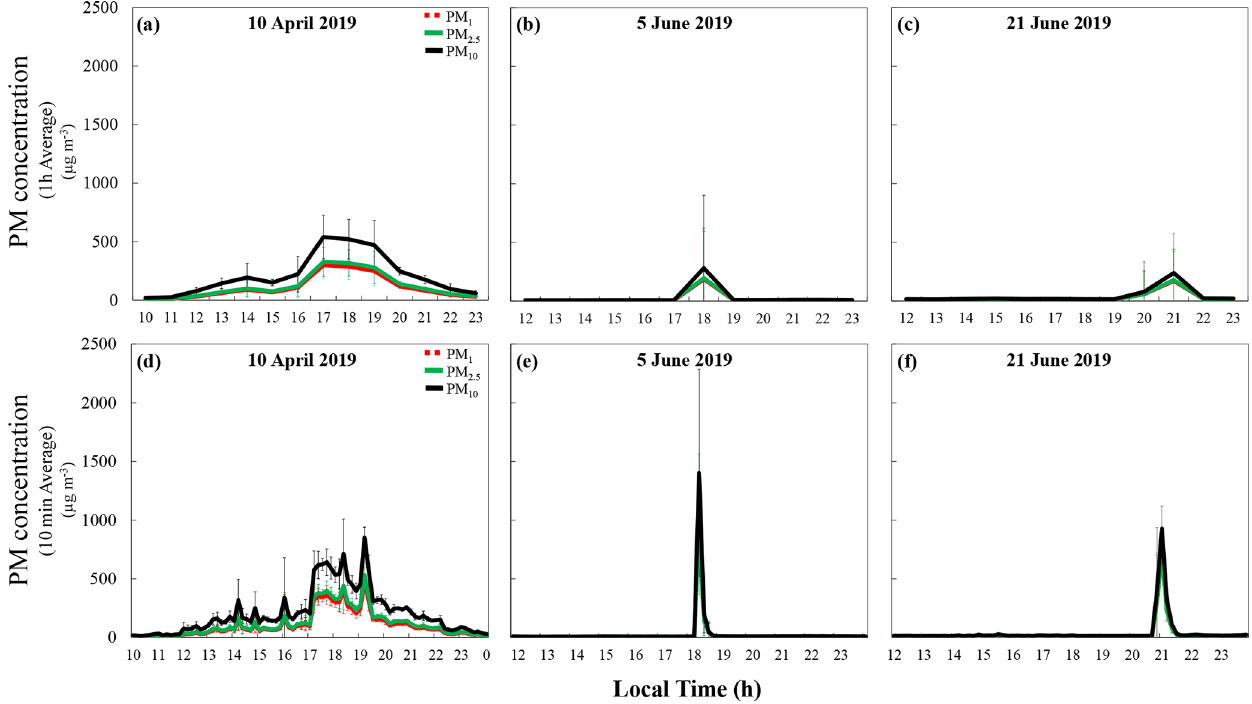
Figure 3. Changes in PM concentration (PM 1 in red, PM 2 . 5 in green, and PM 10 in black) measured by DustTrak during the three dust events, 10 April (a, d) , 5 June (b, e) , and 21 June (c, f) , showing the 1h (a–c) and 10min (d–f)